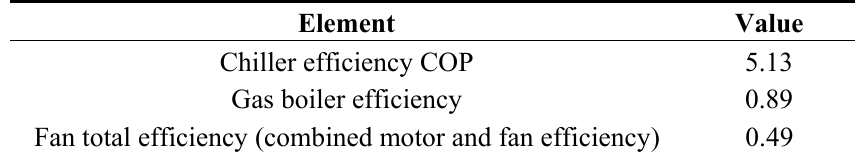
Table A3. Characteristics of the GB 50189–2005 code compliant building model.